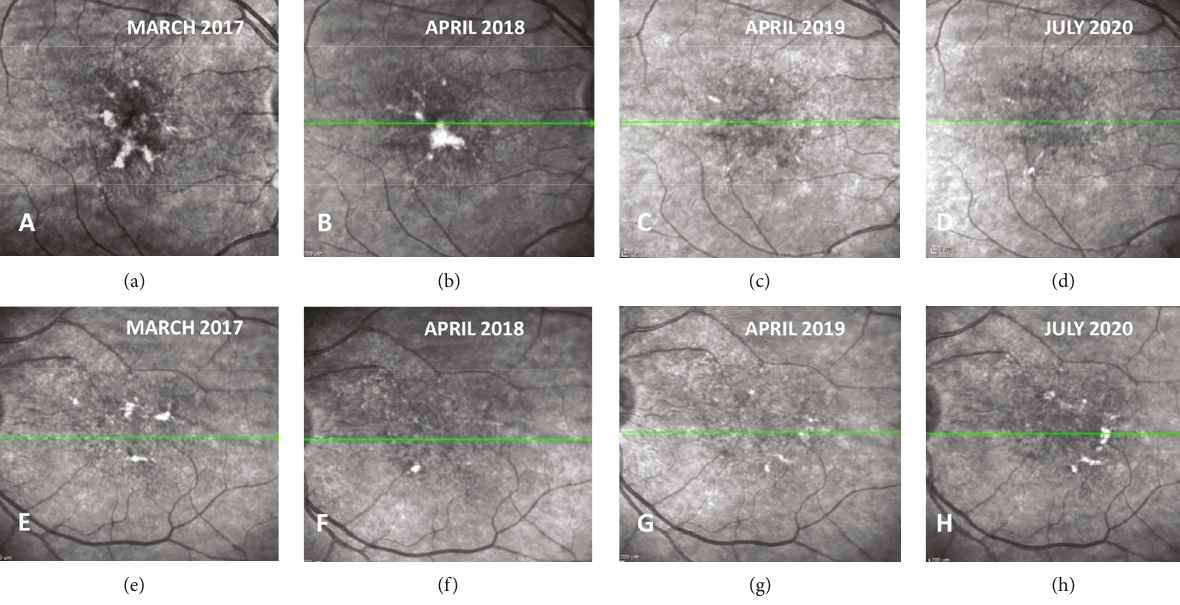
Figure 4: Serial infrared re fl ectance (IR) images demonstrating in the right eye ( fi rst row) central migration and gradual disappearance of vitelliform lesions and the left eye (bottom row) even though lesions disappeared initially, it reappeared at di ff erent locations in the